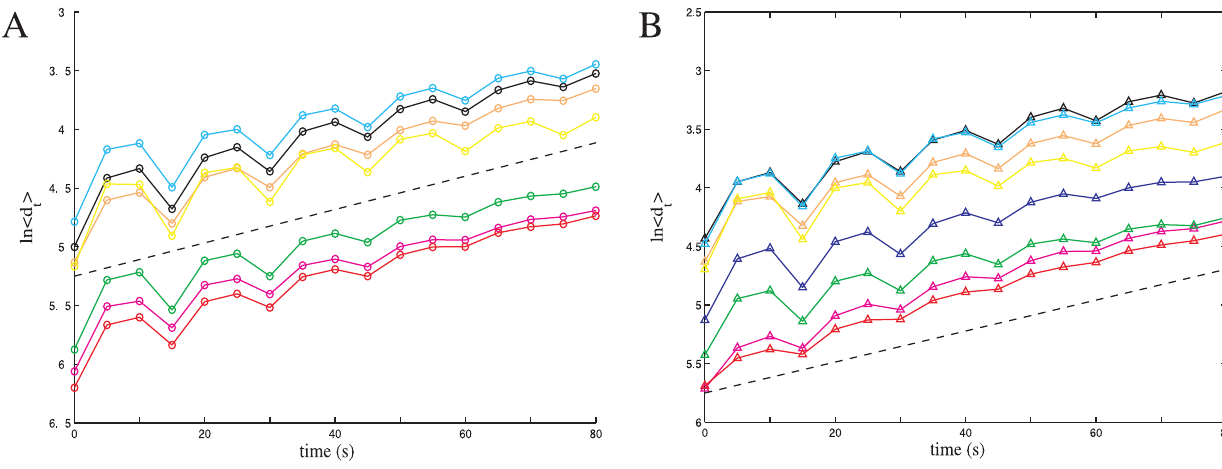
Figure 5. Semi-log plot of the average divergence , d t . of the nearest neighbors of each point in the time series as a function of time. The short term fluctuations are due to the periodicity of the signal, but the average distance clearly grows exponentially. The data points pictured are for an embedding dimension of seven, and consistent values for the maximal exponent are achieved once the dimension is greater than or equal to six. The exponent is 0.0142 for traces detrended with a moving average (A), and 0.0132 for EMD (B). These values are given by the slope of the black dashed lines. For each trace, the exponent was computed as the average of three slopes: 1) the slope through local maxima; 2) the slope through local minima; and 3) the slope through the average of local minima and maxima. The final value of the exponent was computed by averaging over all traces. Computations were not done for traces Nod6 and Nod9 for either detrending because of the short series length. We remark that the same computations for the stochastic spiking model give a semi-log plot of the form , d t . , t 1/A , indicating diffusive-like